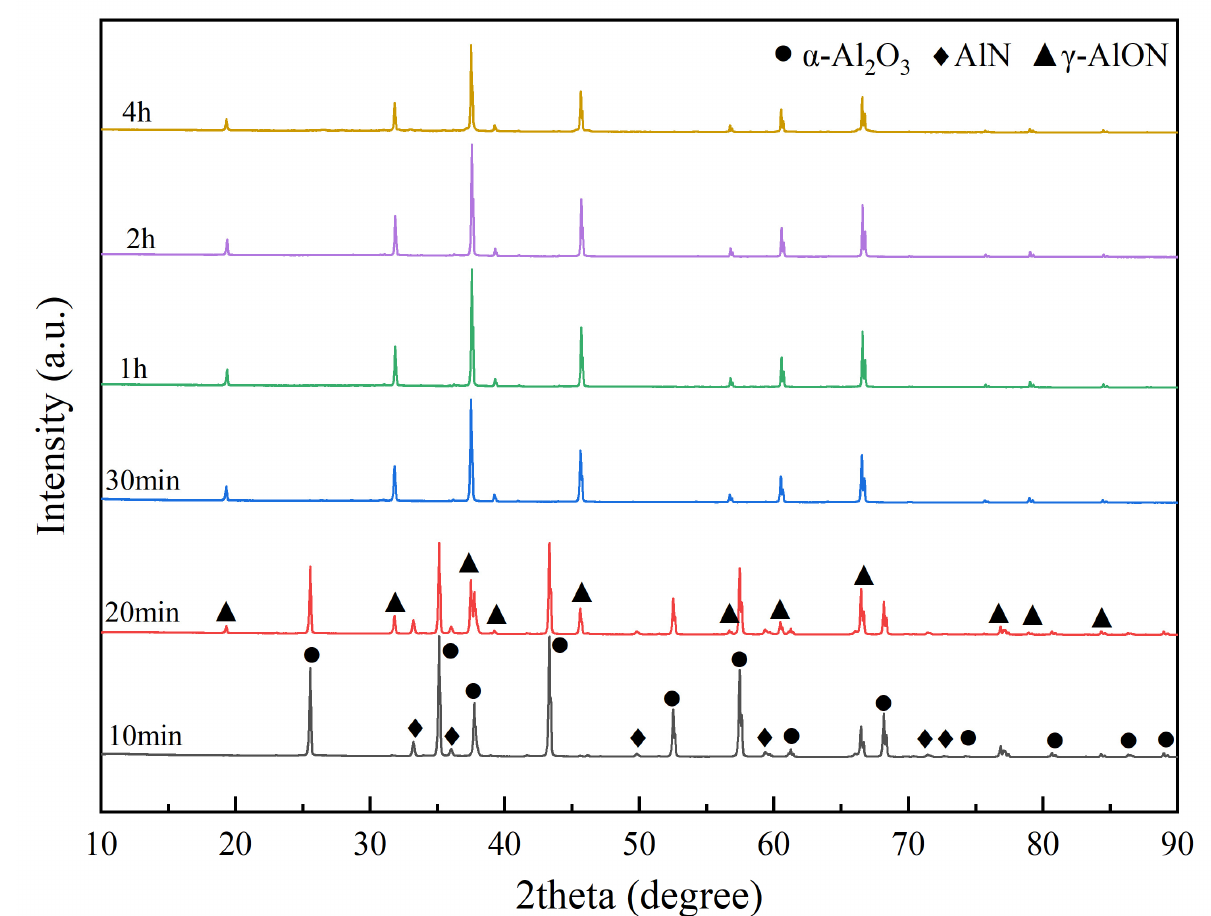
Figure 8. XRD patterns of mixed powders with 5 wt% dispersant at 1670 °C at different time.